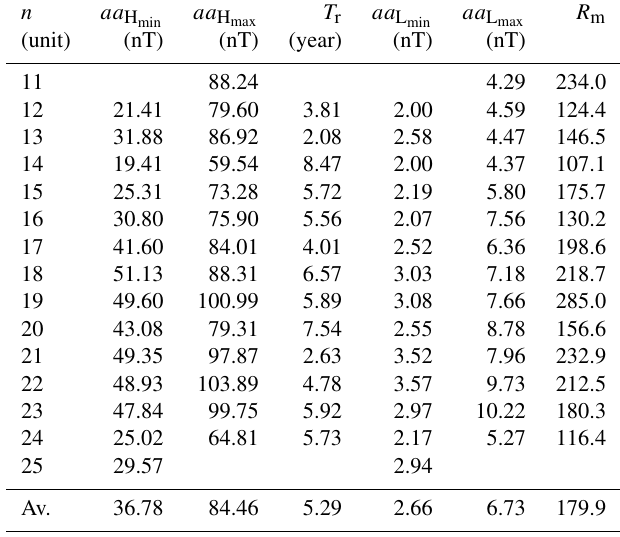
Table 1. The minimum ( aa H ) and maximum ( aa H ) of the 363d smoothed highest 3-hourly aa index ( aa H ) in each 3d, the rise time max min from aa H to aa H ( T r ), the minimum ( aa L ) and maximum ( aa L ) of 363d smoothed lowest 3-hourly aa index ( aa L ) in each 3d, max max min min and the maximum ( R m ) of 13-month smoothed monthly mean R I for solar cycles 11–25. n